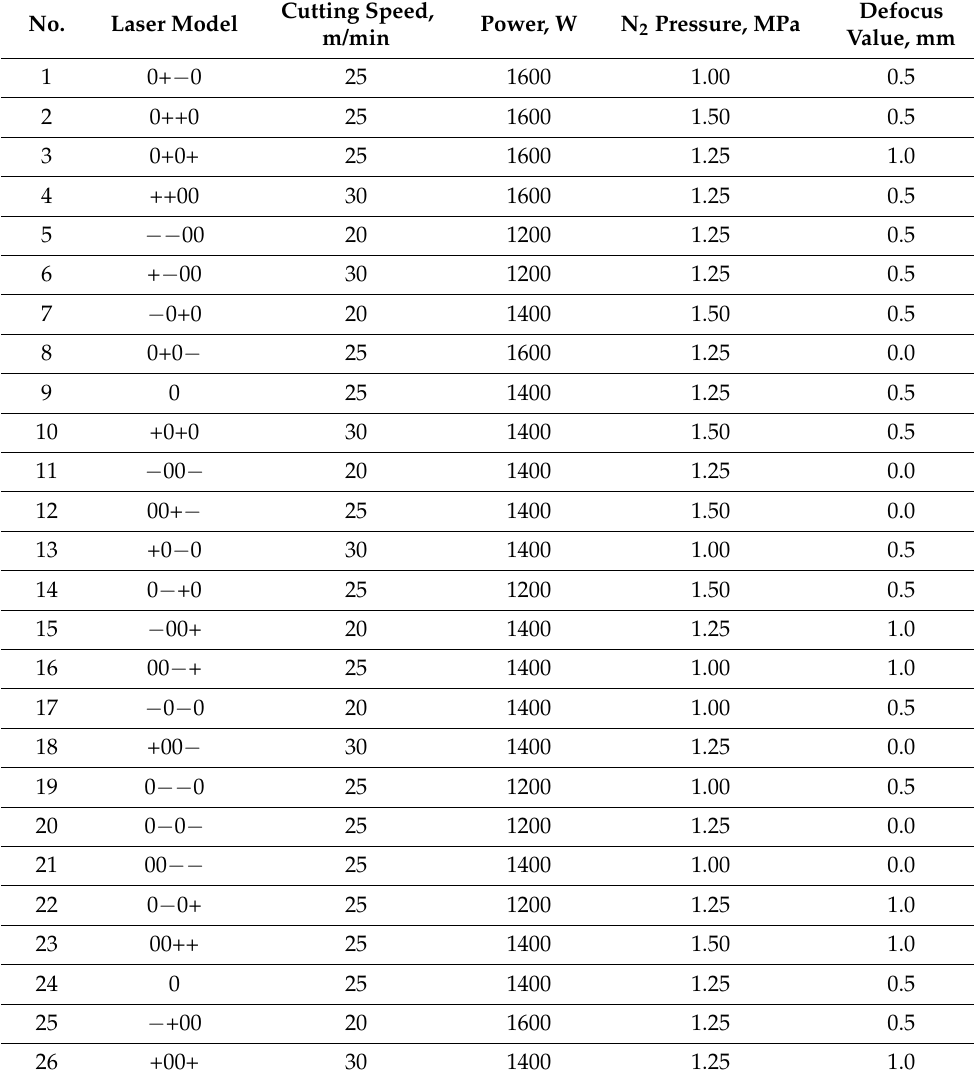
Table 1. Laser cutting parameters utilized in this work. +, 0 and − represent the maximum, middle and minimum values of the varying parameter,